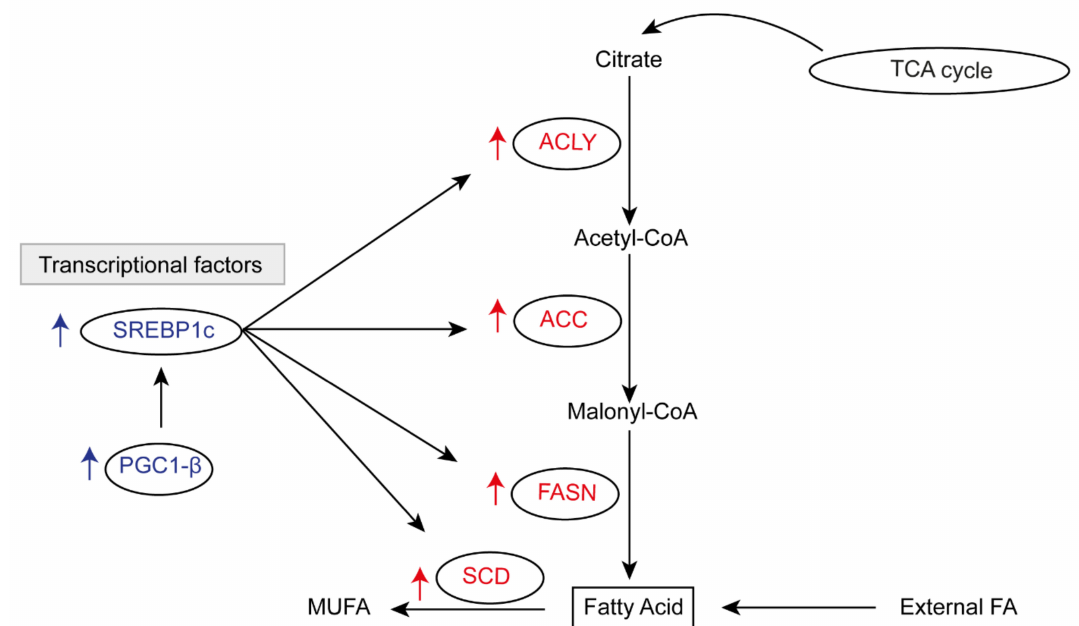
Figure 1. Enhancement of fatty acid synthesis in hepatocellular carcinoma (HCC). ATP citrate lyase